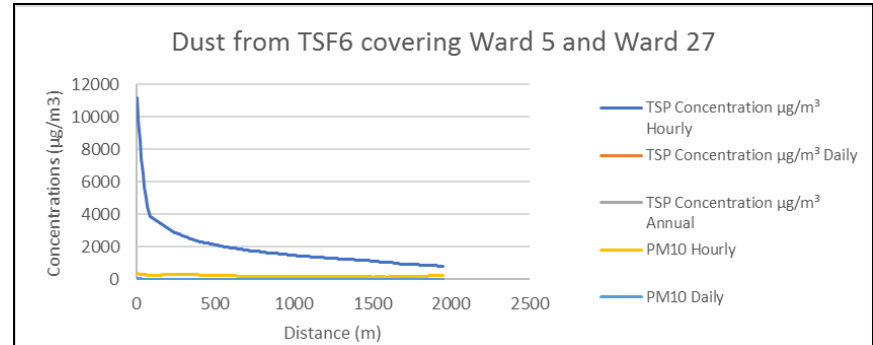
Figure A3. Distance covered by dust in the mine village. Table A3. National Ambient Air Quality Standard for Particulate Matter (PM 10 ).